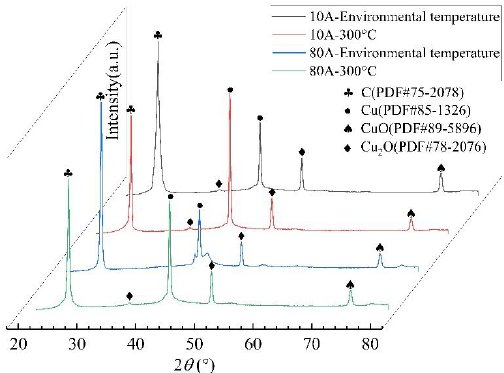
Figure 6. XRD patterns of the carbon surface with different temperature and current.